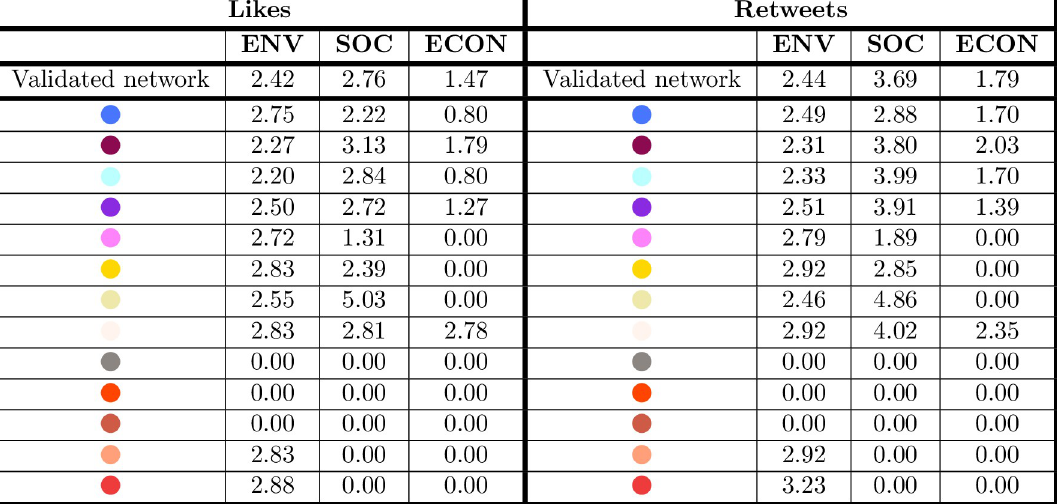
Fig 11. Average number of likes (left) and retweets (right) per message containing a hashtag in the environmental (ENV), social (SOC) and economic (ECON) dimensions. Interestingly enough, the frequency of the CSR hashtags used (reported in the table of Fig 10) is not necessarily mirrored in the number of likes or retweets received on average per